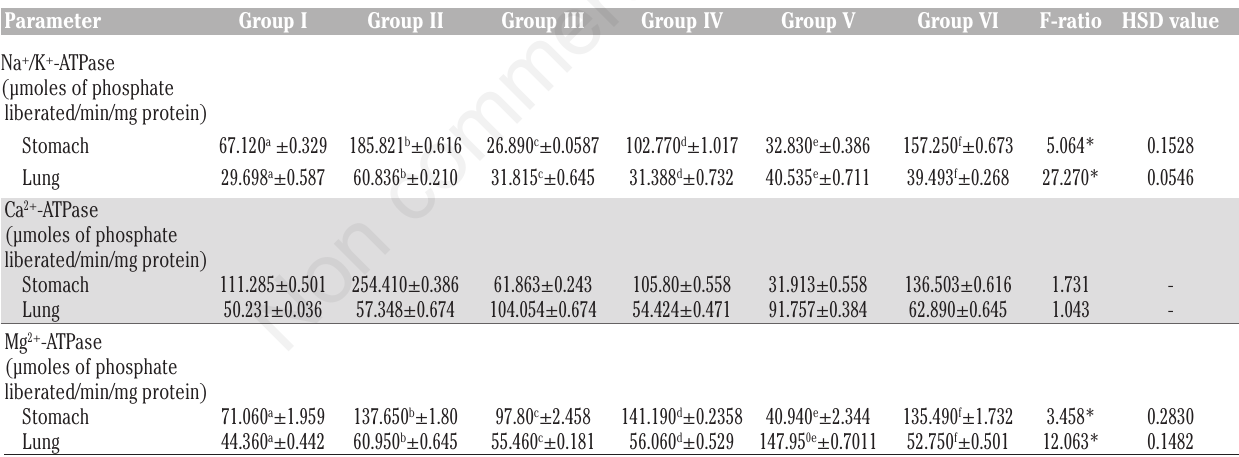
Table 2. Modulation of DMBA induced impairment of membrane bound ATPases by betulinic acid among different treatment groups of female Sprague Dawley rats. Parameter